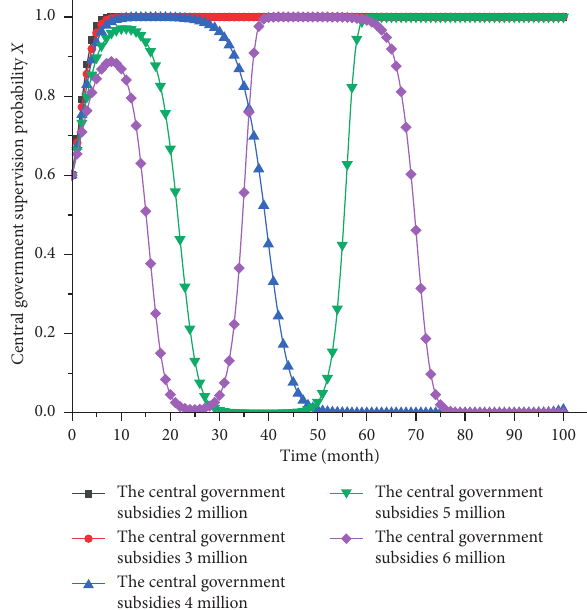
Figure 12: The impact of central subsidies on central government strategy choices.